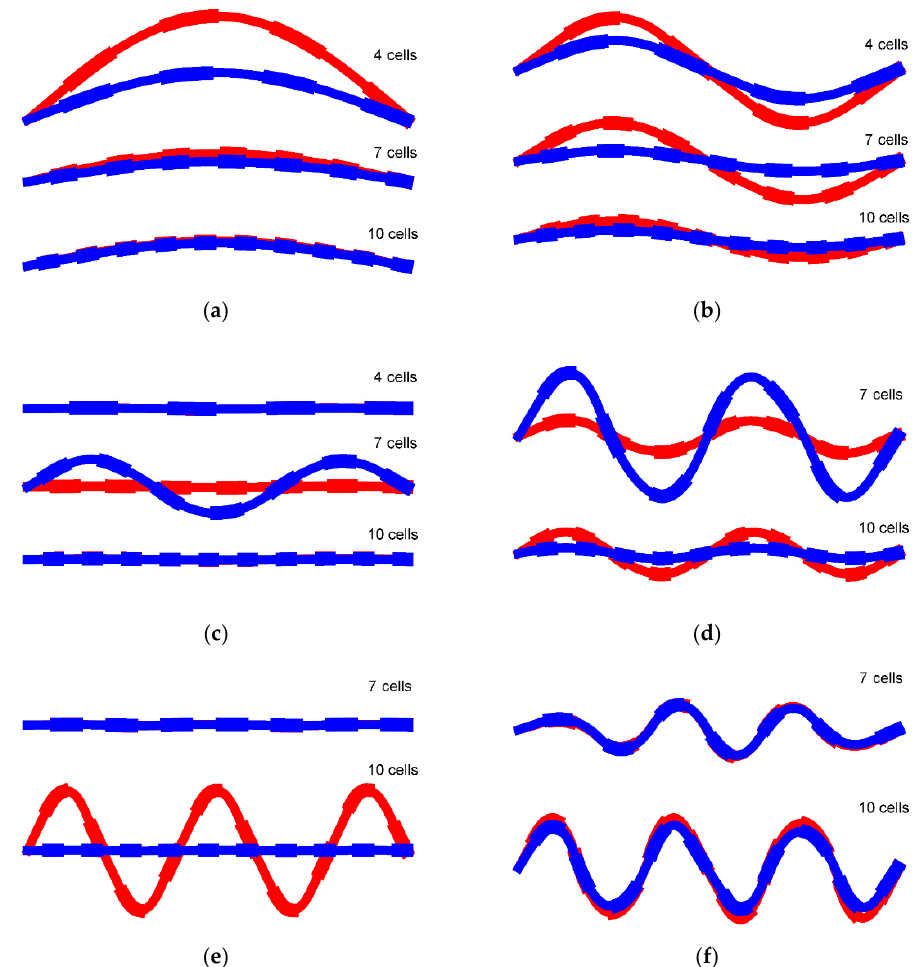
Figure 10. Mode shapes of the fluid-conveying periodic pipe with different numbers of cells: ( a ) Mode 1, ( b ) Mode 2, ( c ) Mode 3, ( d ) Mode 4, ( e ) Mode 5, ( f ) Mode 6. Blue— U = 20 m/s, Red—without fluid loading.